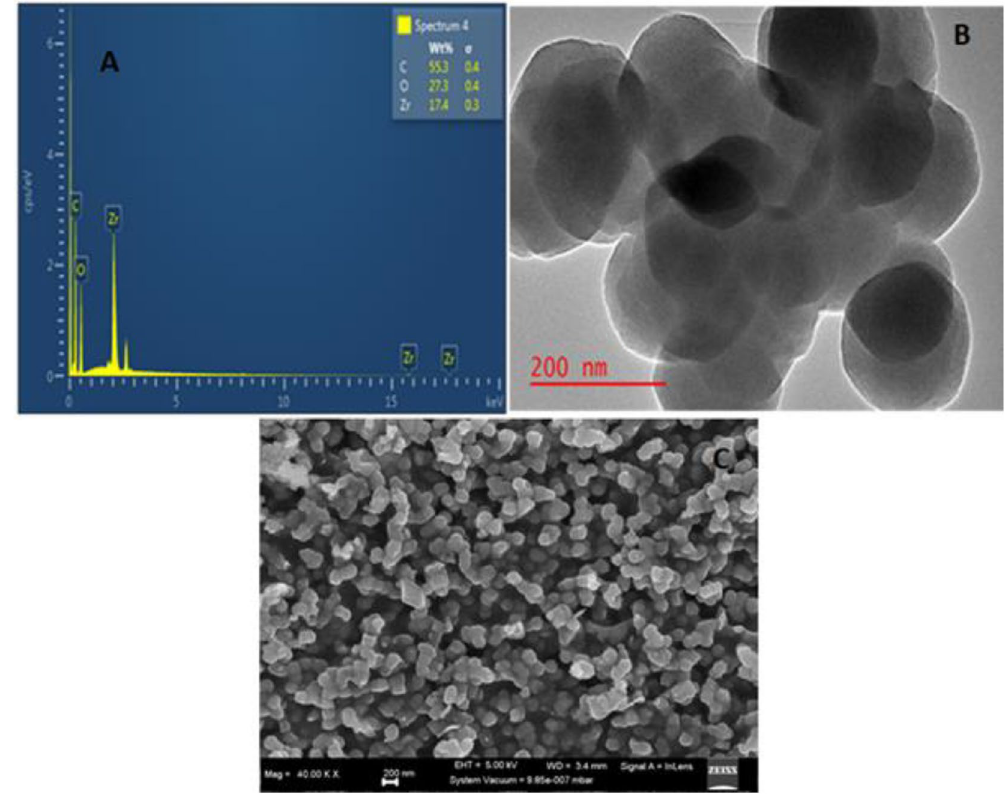
Figure 1. ( A ) EDS, ( B ) TEM and ( C ) HR-SEM image of PET based